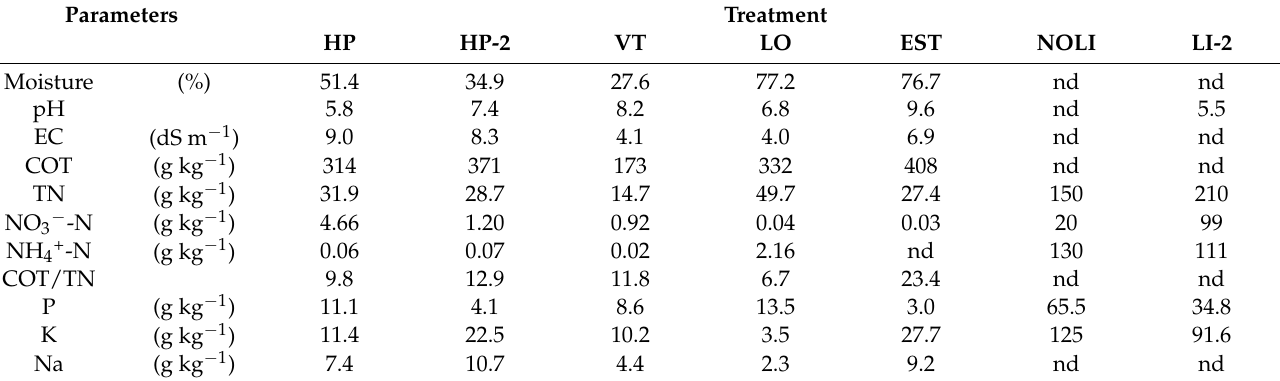
Table 2. Characteristics of the fertilizers used in the experiment (dry weight